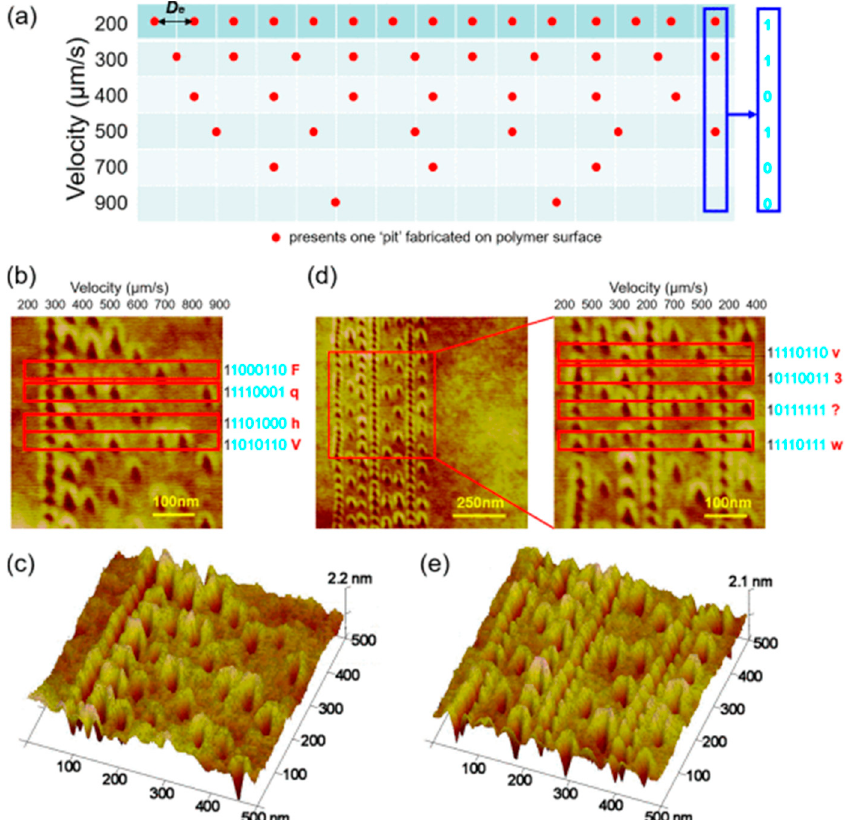
Figure 18. Creating 8-bit American Standard Code for Information Interchange (ASCII) codes by DPL method scratching on PMMA thin-film using different velocities: ( a ) schematic of the nanoscale pits fabrication with various scratching velocity, ( b ), ( c ), ( d ) and ( e ) morphologies and 3D images of fabrication results for arrays of pits on polymethyl methacrylate (PMMA) film surface [83] .